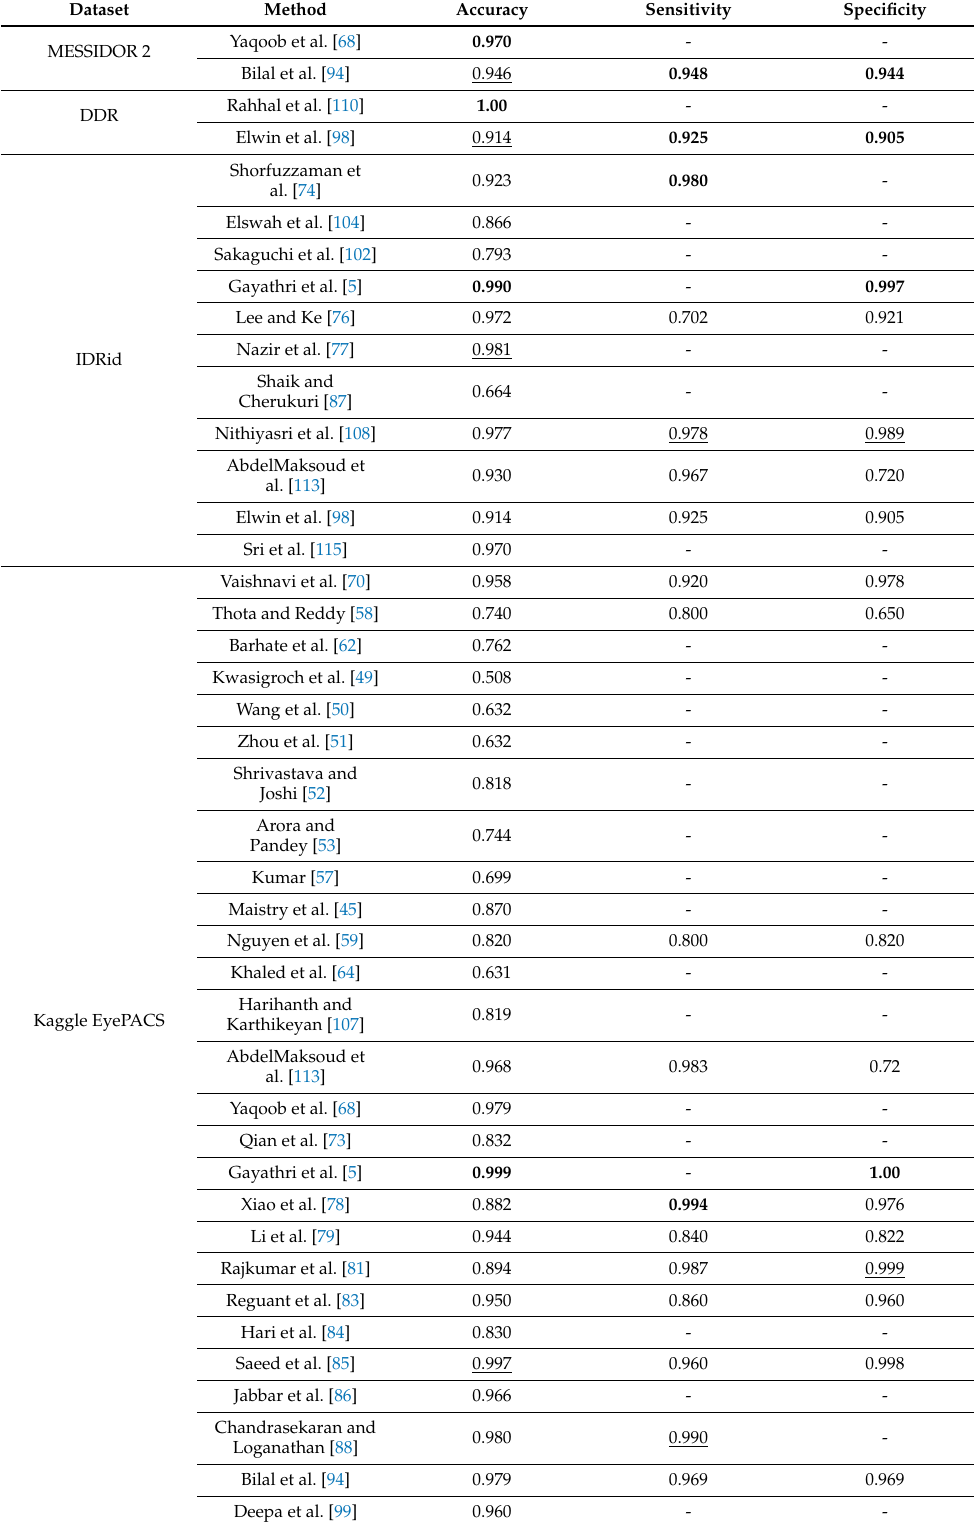
Table 4. Performance comparison of diabetic-retinopathy-grading-based studies that used the Kag- gle APTOS, MESSIDOR2, DDR, and IDRid datasets. The bold and underlined fonts, respectively, represent first and second